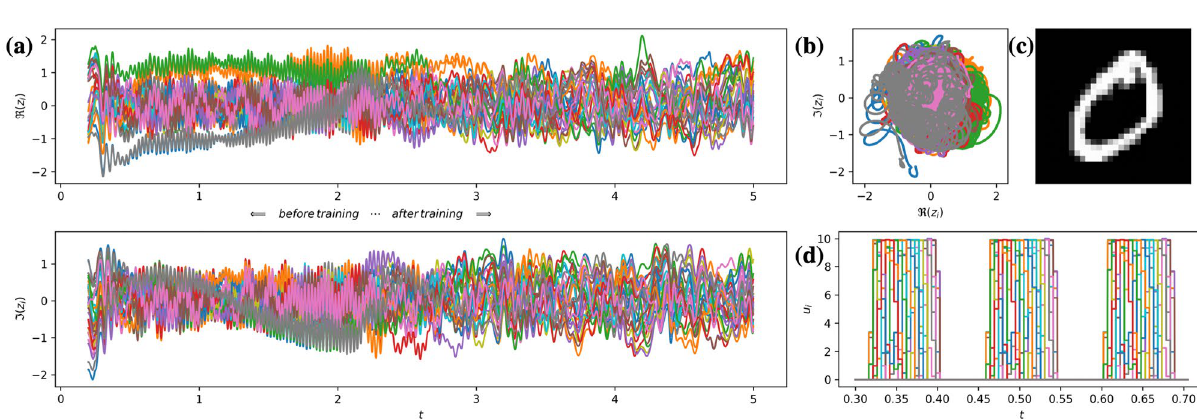
Figure 5. Behavior of the STO-network under the MNIST-input. (a) Time series of the real and imaginary parts of z under two different interconnection topologies (before and after the training). The switch between the 2 ns. (b) Phase space representation of z . (c) Graphical representation of the used topologies is performed at t = MNIST digit. (d) Periodic input u that corresponds to the chosen MNIST digit (see section Methods for details on the input